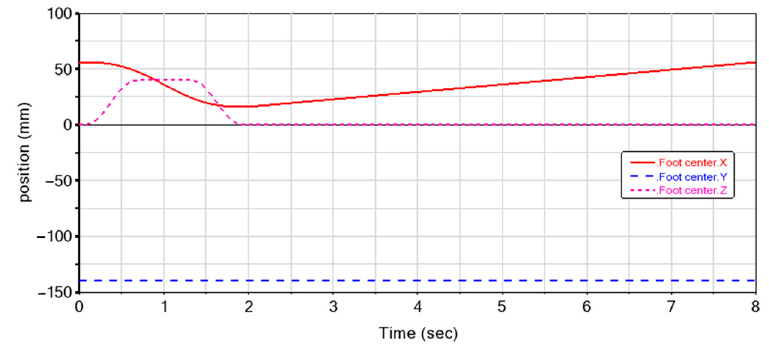
Figure 7. Variation of foot positions in three axes in simulations.